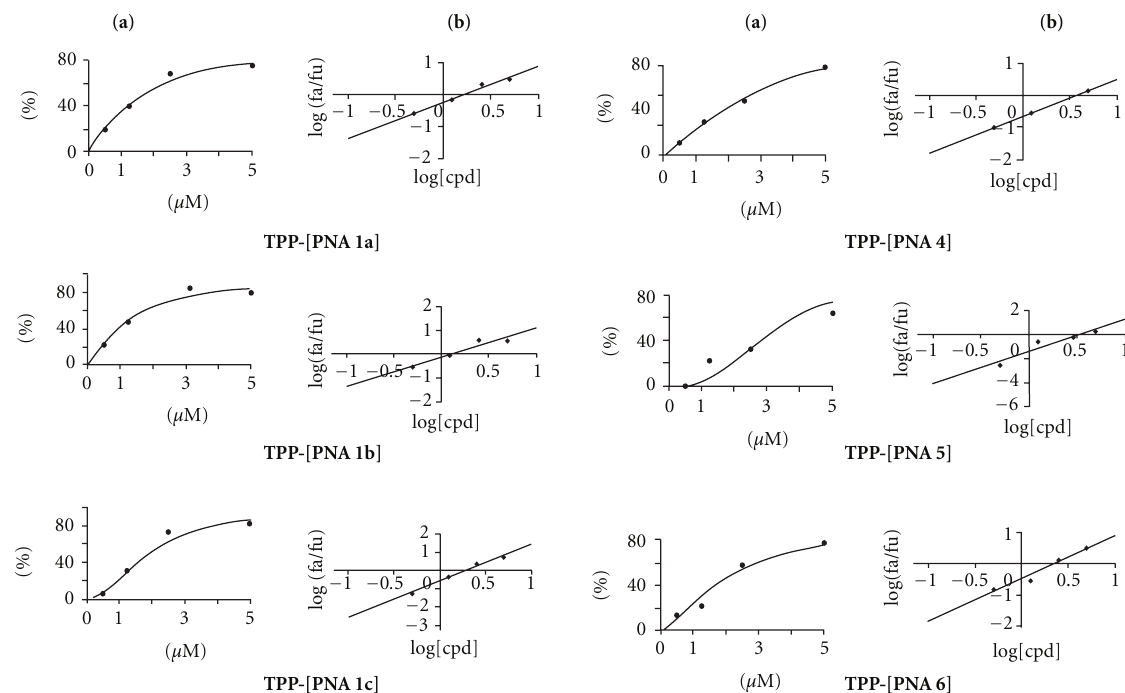
Figure 6: Dose-e ff ect curves and median-e ff ect plots for antiviral activity of TPP-conjugates. CEM cells were infected with VSV-G pseudotyped S1 strain of HIV-1 and grown in the presence of increasing concentrations of test conjugates. After 48 h, cells were harvested and assayed for luciferase expression using Luciferase assay kit (Promega). The e ff ect of conjugate concentrations on the luciferase expression was analyzed using CalcuSyn software (Biosoft). The IC 50 values, determined from the ratio of log of luciferase expression in treated cells (fa) and untreated cells (fu) as a function of the log concentration of conjugates was 1.0 > M ; the linear correlation coe ffi cient, r , ranged from 0.943 to 0.985. (a) Dose-e ff ect curves for antiviral activity of TPP conjugates. (b) Median-e ff ect plot.